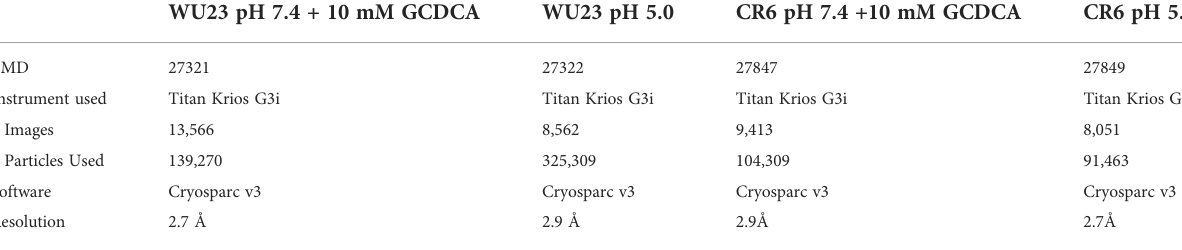
TABLE 1 Data collection and re fi nement statistics.